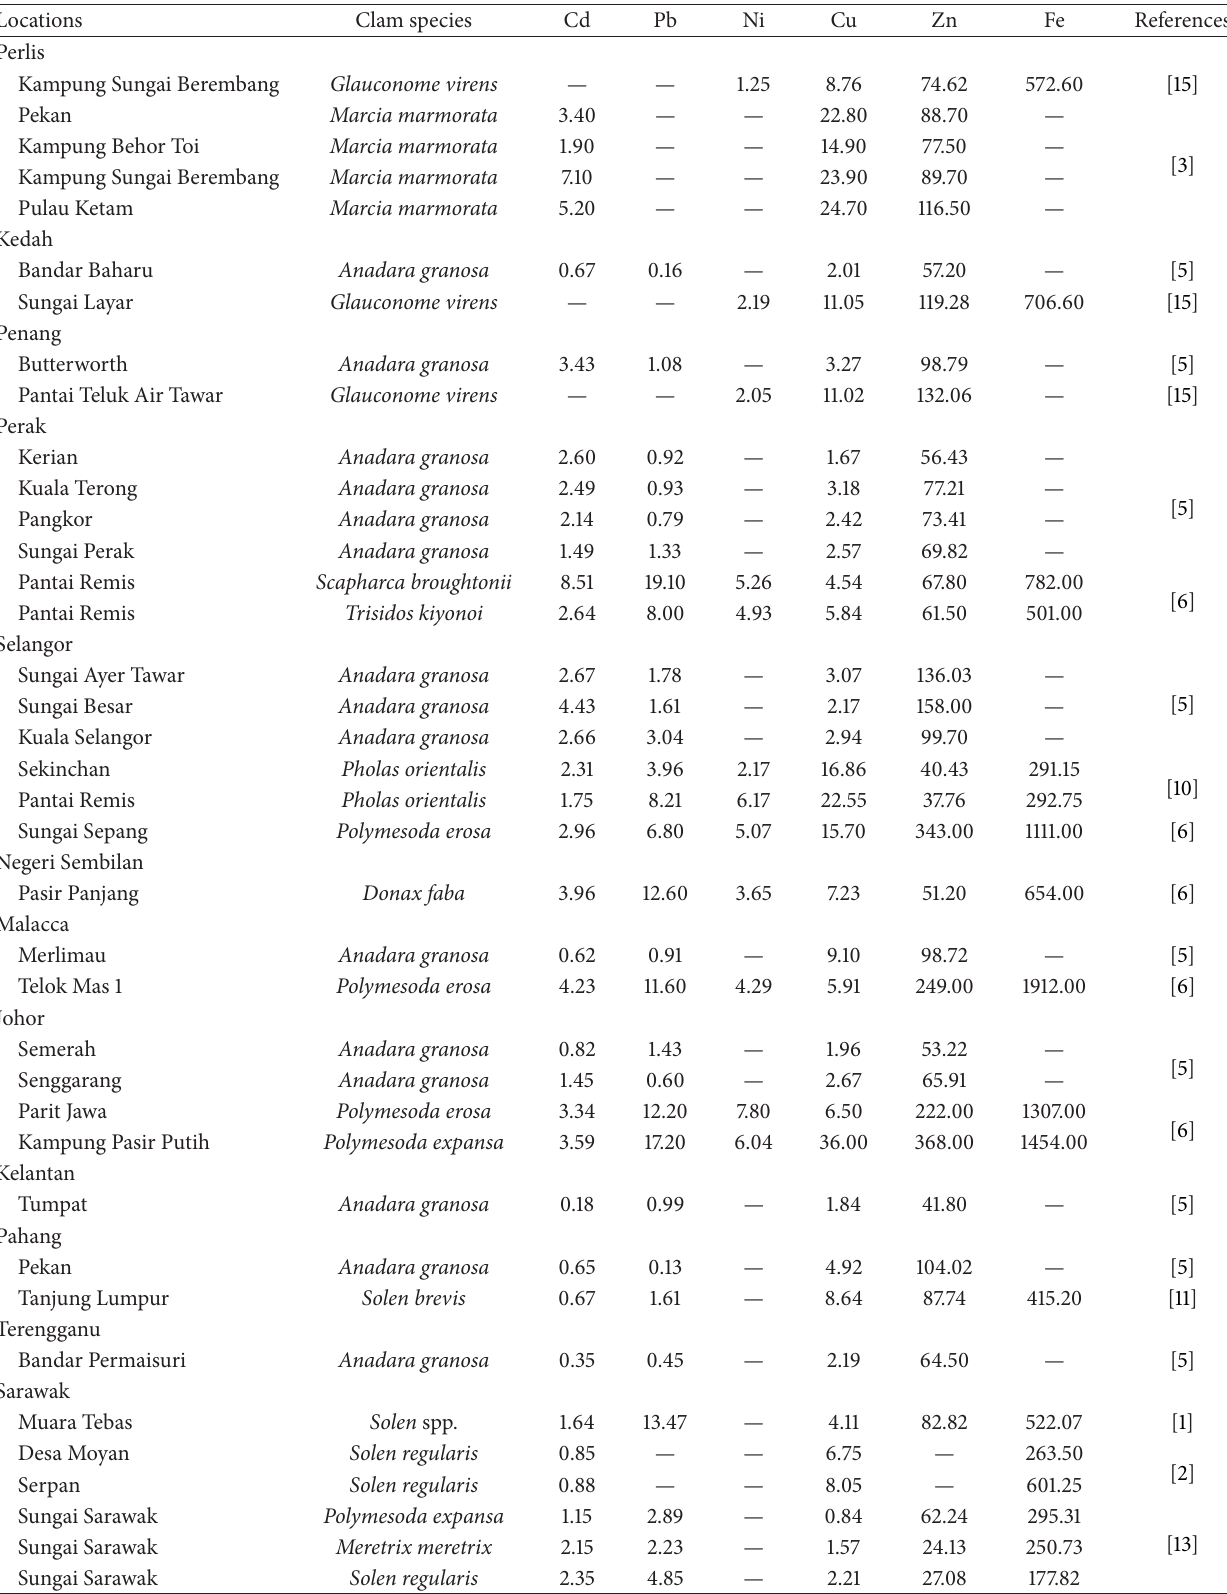
Table 1: Mean concentration of metals ( 𝜇 g/g dry weight) in total soft tissue of different clam species from